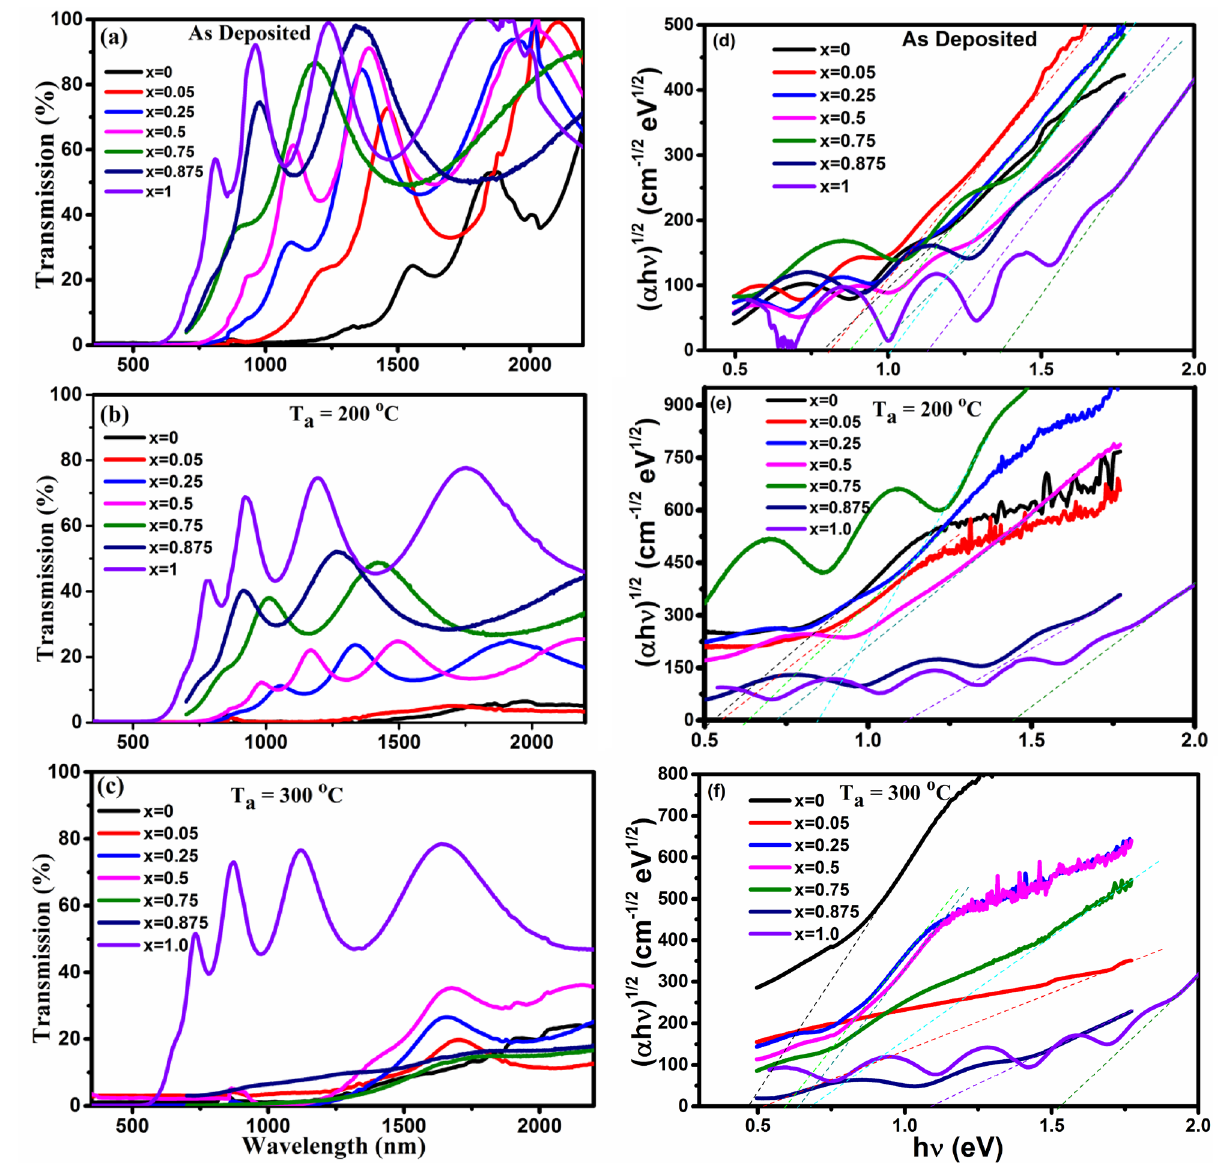
Figure 6. Transmission spectra of the GeTe 1−x Se x films ( a ) as deposited and annealed films ( b ) at 200 °C and ( c ) at 300 °C. The corresponding Tauc plot are shown in ( d )–( f